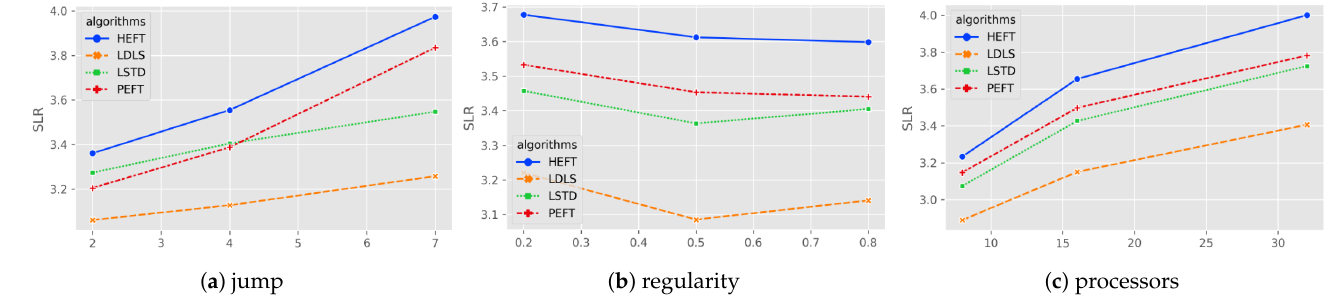
Figure 3. Average SLR for random graphs of ( a ) maximum jump between level ; ( b ) regularity of DAG; ( c ) number of processors.